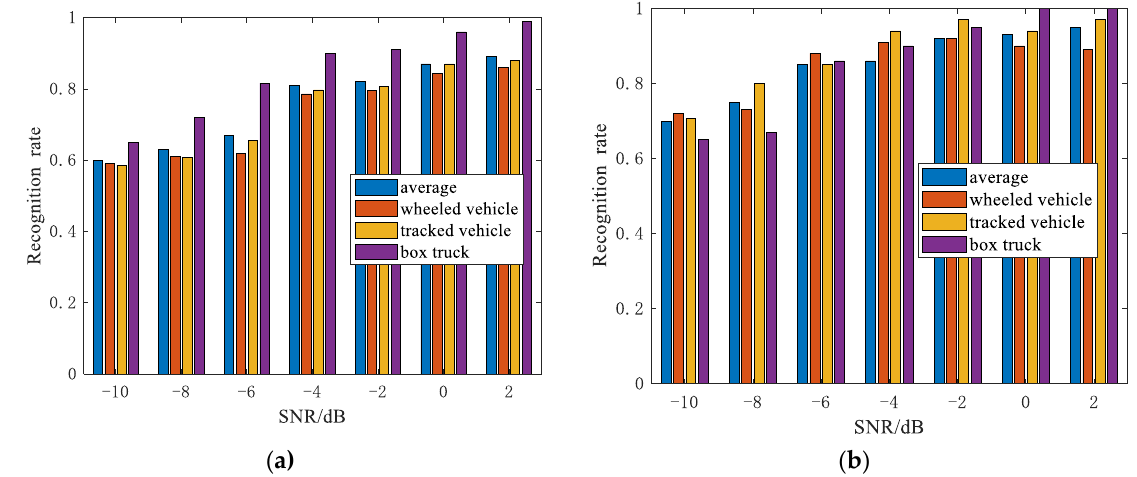
Figure 9. Recognition rate of the three vehicles: ( a ) before the two-dimensional variational mode decomposition (2D-IVMD) procedure and ( b ) after the 2D-IVMD